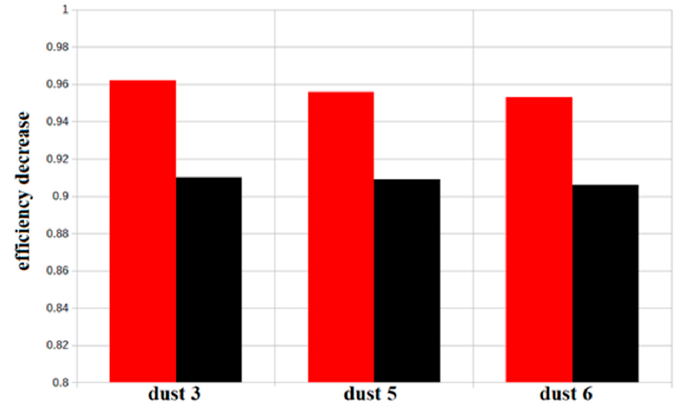
Figure 8. Efficiency decrease η / η 0 for surface dust density of around 10.4 g/m 2 covering PV module: ( ♦ ) MWG-20 and ( ♦ ) CLC010-12P.